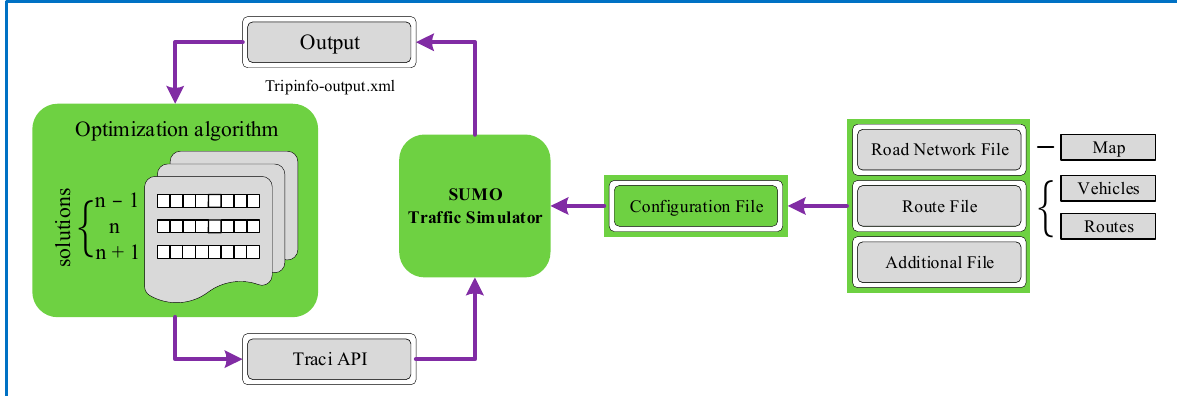
Figure 3. Theory of simulation using SUMO traffic simulator.